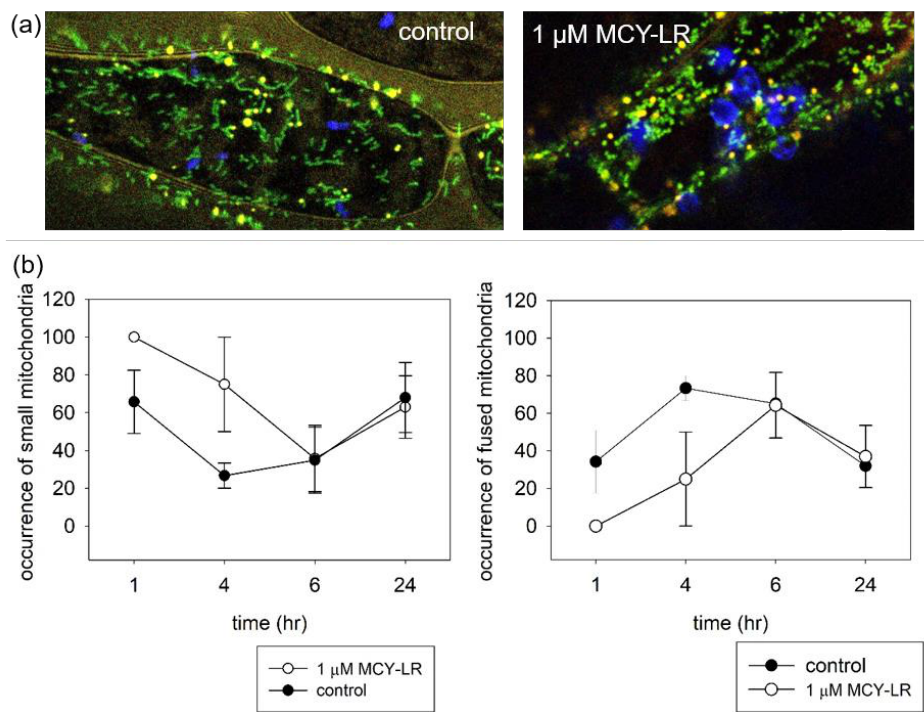
Figure 3. Short-term (1–4 h) MCY-LR treatment induces mitochondrial fission or inhibits fusion. ( a ) CLSM microscopic images of hypocotyl cells showing mitochondria (green), peroxisomes (yellow) and chloroplasts (chlorophyll autofluorescence, pseudo-colored in blue). Control cells show mainly long/fused mitochondria, while in the presence of 1 µM MCY-LR (1 h exposure), mostly small, round-shaped mitochondria occur. Scalebars: 10 μm. ( b ) Time-course of the frequency of small and fused mitochondria, respectively.